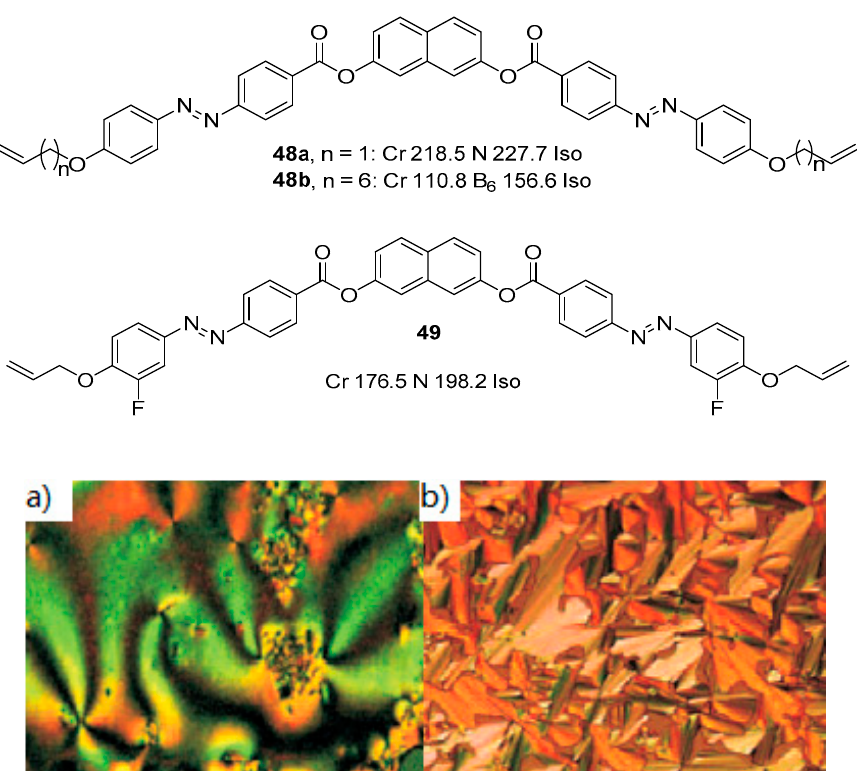
Figure 14. Optical textures taken for ( a ) compound 48a in the nematic phase at T = 155 °C and ( b ) compound 48b in the B 6 phase at T = 142 °C (Reproduced with permission from ref. [122], copyright John Wiley and Sons 2014, https://doi.org/10.1002/jccs.201300191).